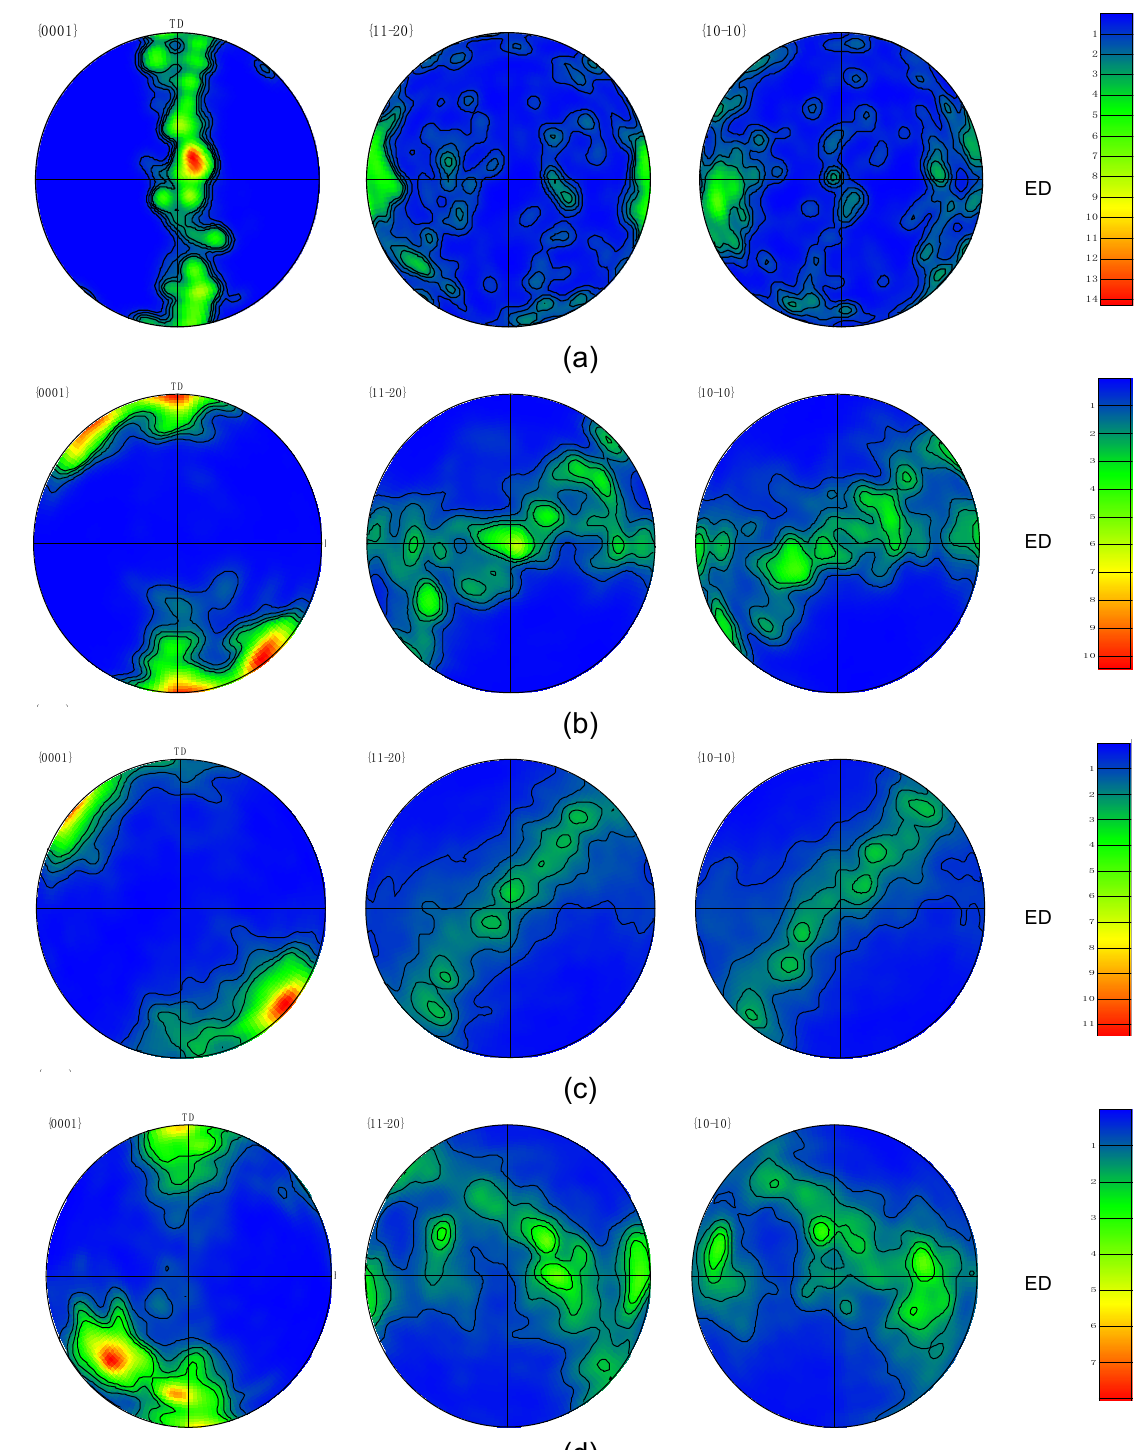
Figure 9. {0001}, {11-20}, and {10-10} pole figures showing the crystallographic texture of ( a ) AA, ( b ) 1-P, ( c ) 2-Bc, ( d ) 4-Bc.